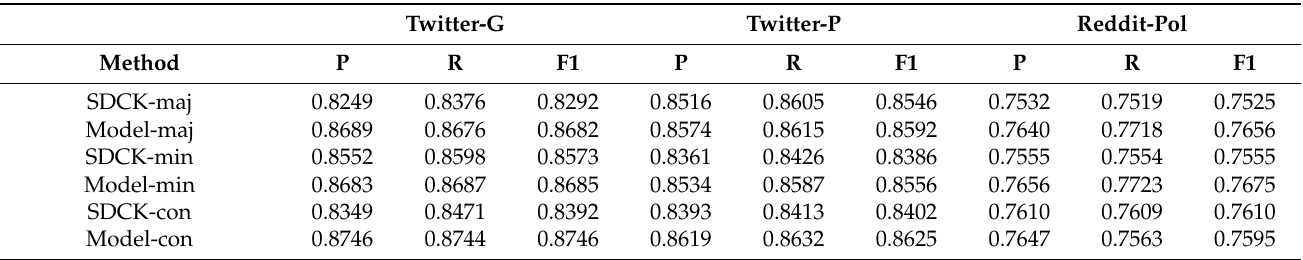
Table 4. The experimental results of our incongruity extraction module are combined with the knowledge selection strategy.